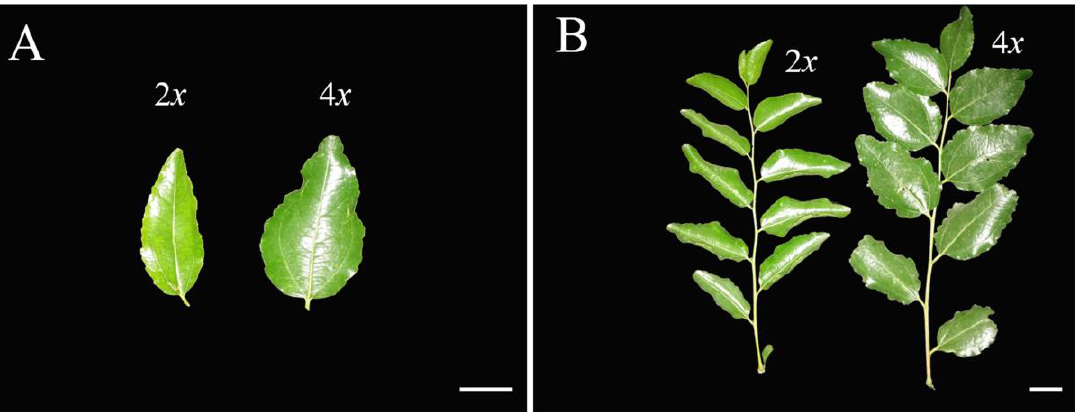
Figure 5. Morphological changes of ‘Xingtai 0604′ (2 x ) and ‘Zhuguang’ (4 x ) leaves and bearing shoot. ( A ): leaves; ( B ): bearing shoot, bars = 2 cm.